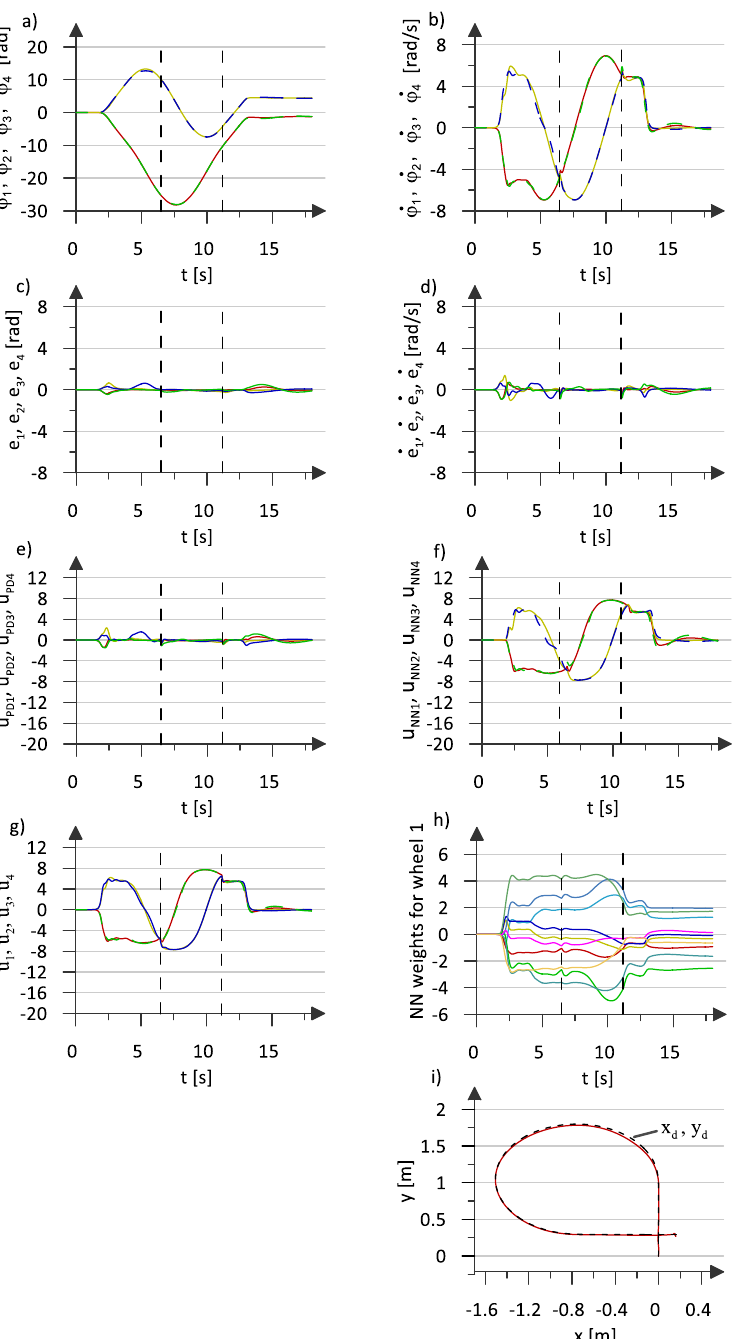
yellow, wheel 2; blue, wheel 3; and green, wheel 4.